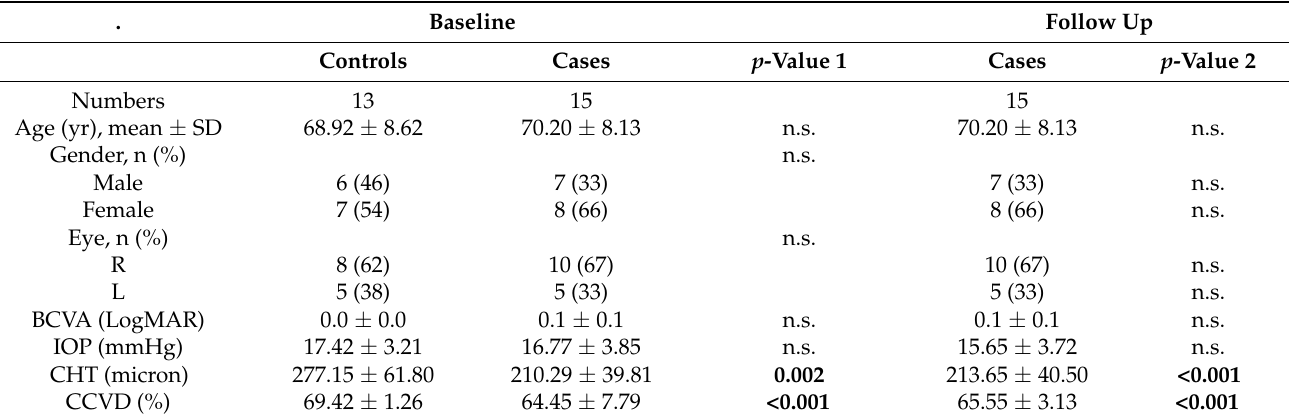
Table 1. Demographic and clinical features.